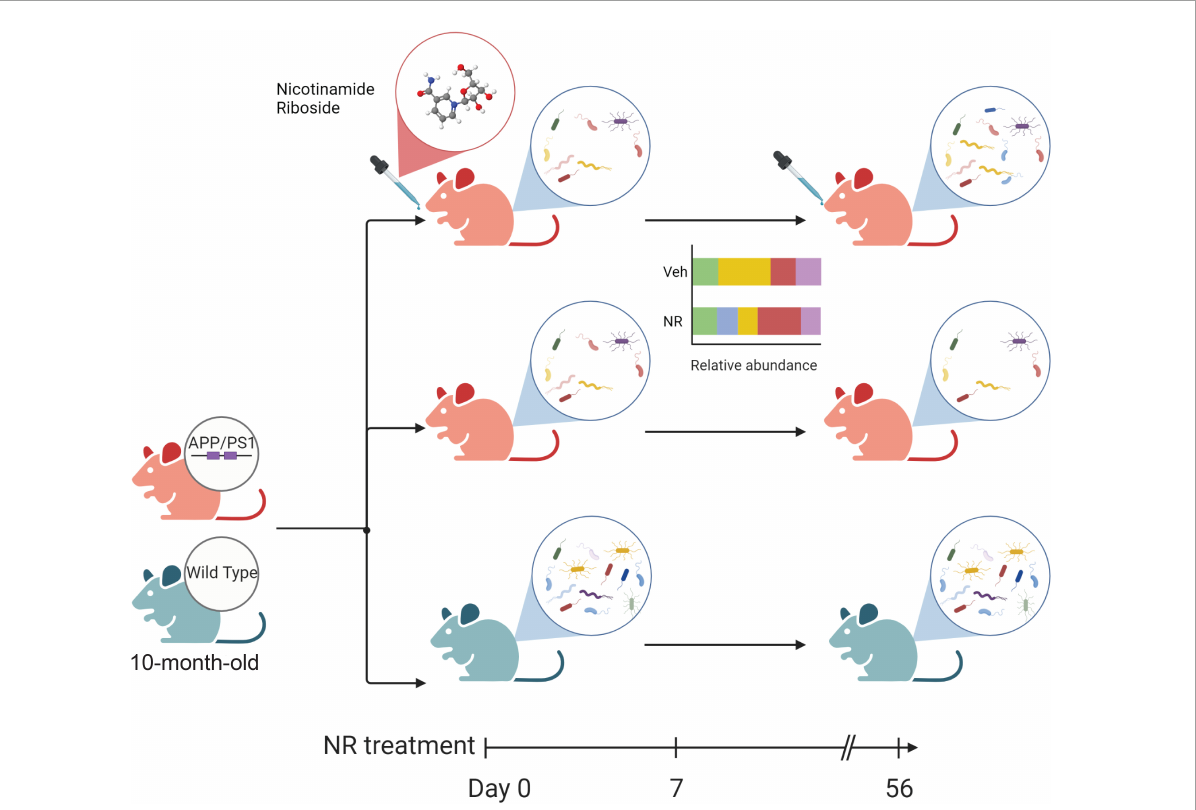
FIGURE8 The schematic diagram of the main changes in the gut microbiome associated with nicotinamide riboside (NR) treatment in Alzheimer’s disease (AD) mice. The green mouse denotes the wild-type (WT) group, and the red mouse denotes the AD group in this study. Firstly, AD mice show decreased diversity compared with WT. NR could restore the richness and diversity of the gut microbiome in AD mice after 8 weeks of NR treatment. Additionally, NR could shift the relative abundance of some gut microbiomes which may favor an anti-inflammatory gut micro-environment, as shown in the simplified bar plot. NR can also specifically affect the gut flora of AD mice, as shown in Supplementary Figure 2 . These changes may directly or indirectly influence the balance of intestinal flora and contribute to